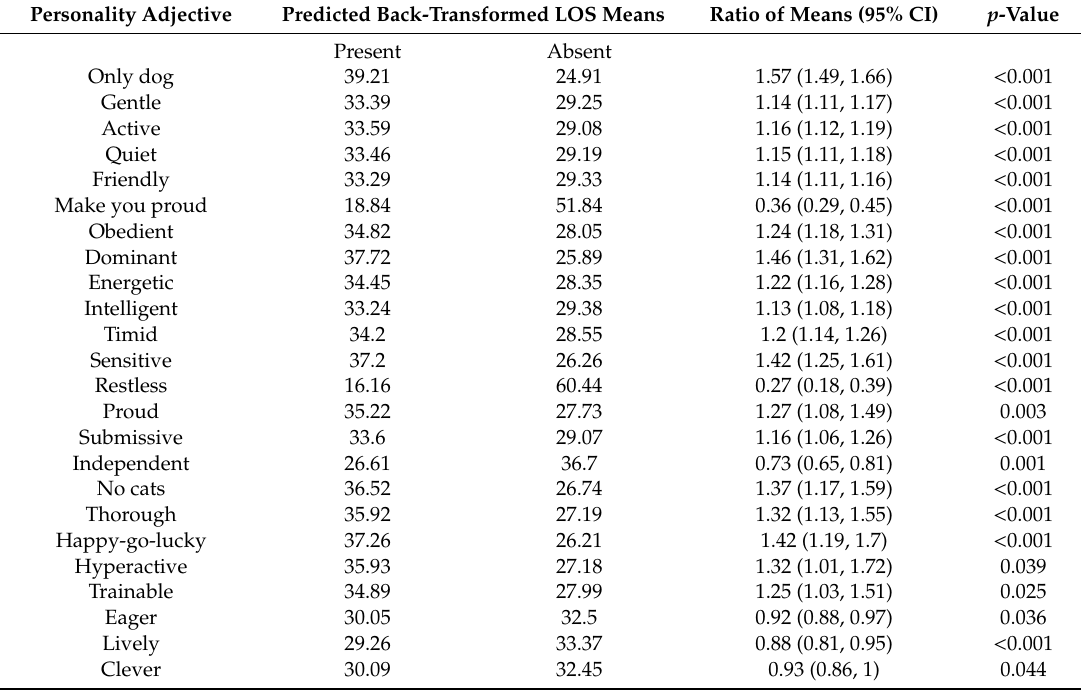
Table 3. Results of the final multivariable model of the association of individual personality adjectives (whether present or absent) addressed in descriptive texts ( n = 24) relative to LOS of 70,733 shelter